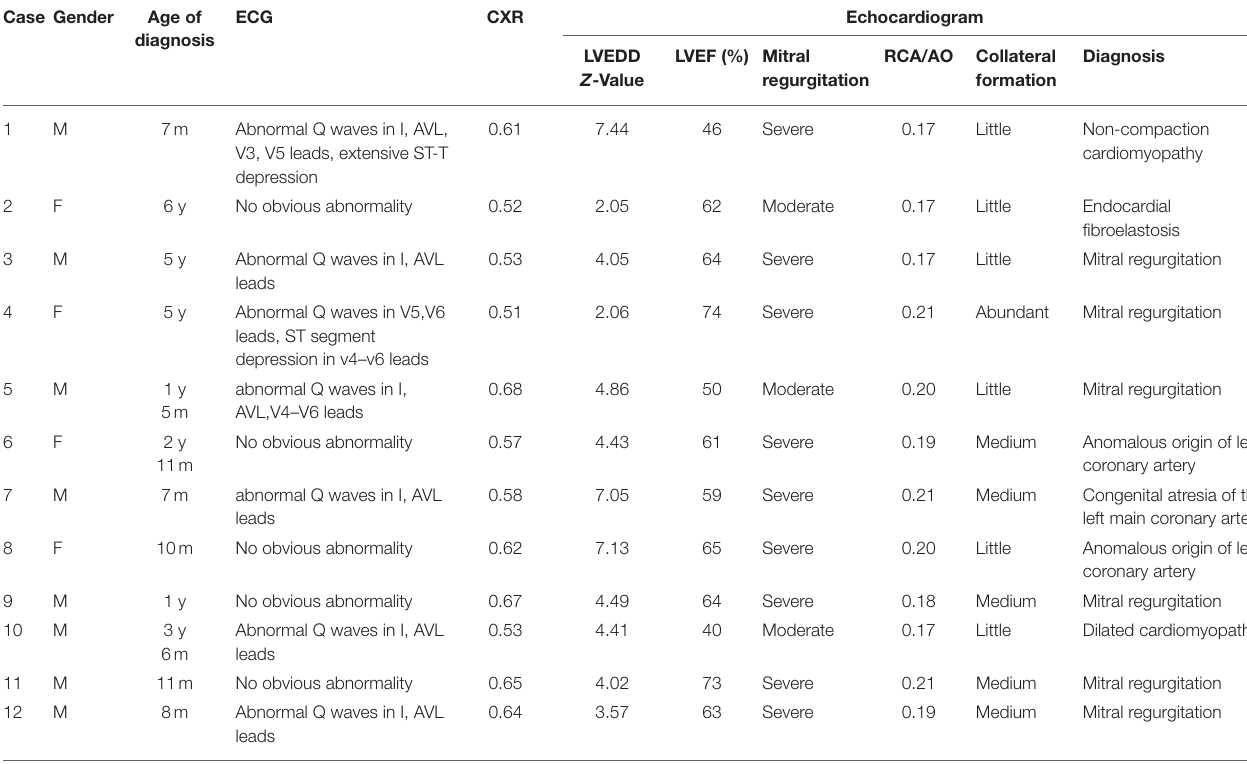
TABLE 2 | Echocardiogram, ECG, and X-ray cardiogram in 12 children. Case